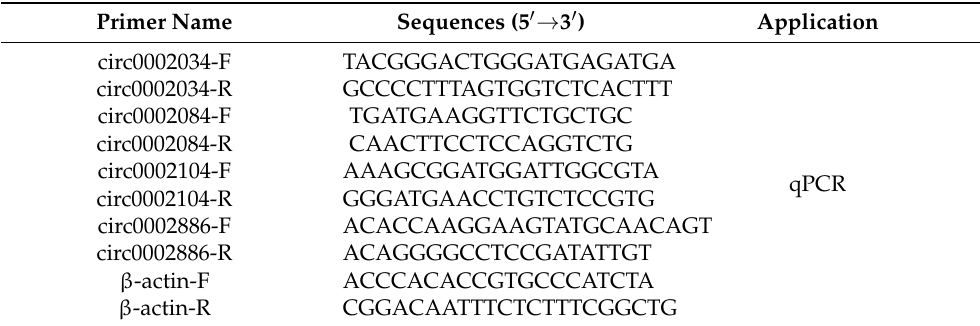
Table 3. Primer sequences used in qPCR